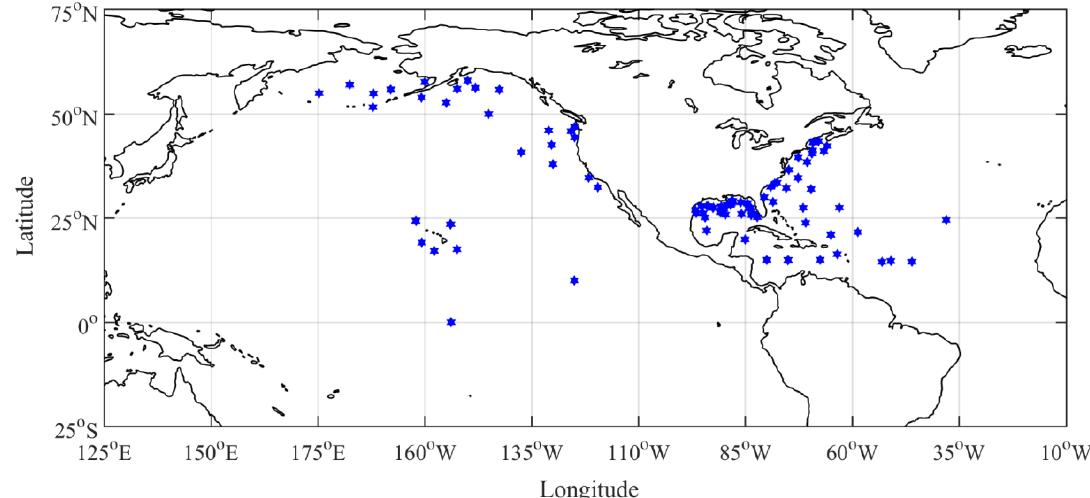
Figure 2. Locations of the NODC buoys (blue stars) used in this study where only buoys more than 50 km offshore are used.